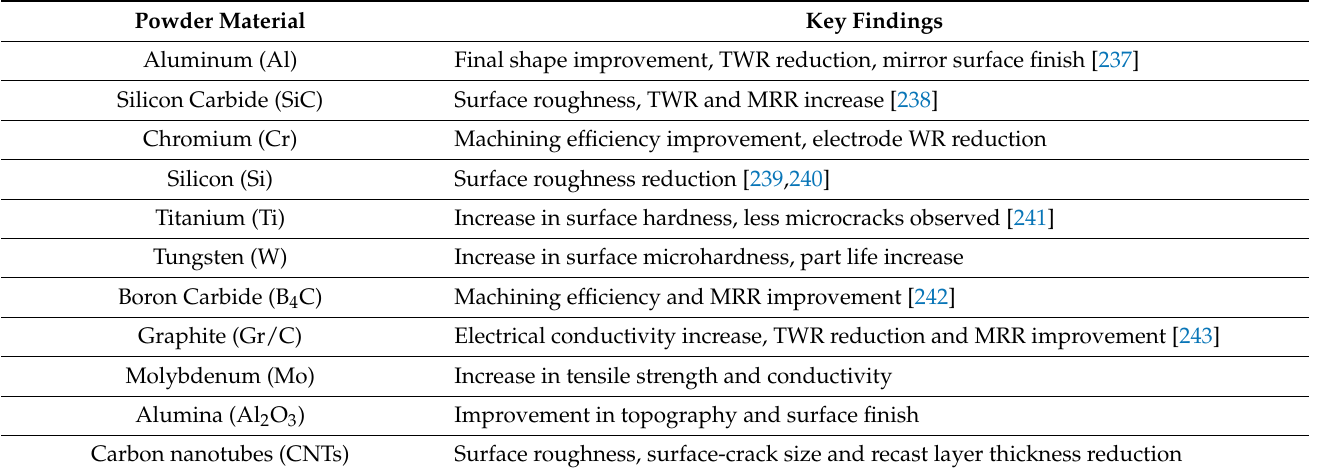
Table 17. Summary for different powder materials.